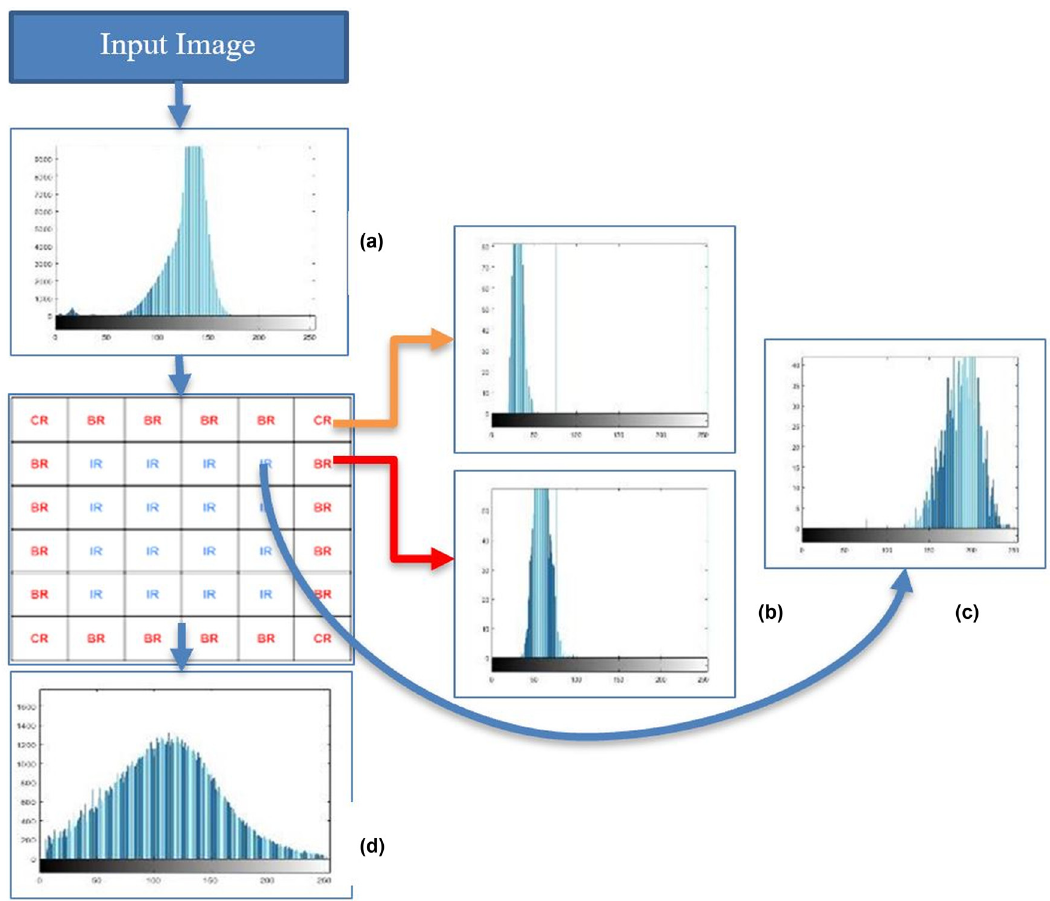
Figure 5: Histogram representation for every block of the input image ( a ) . ( b ) The histogram for the border blocks, ( c ) the histogram for the inner blocks, and ( d ) the histogram for the output